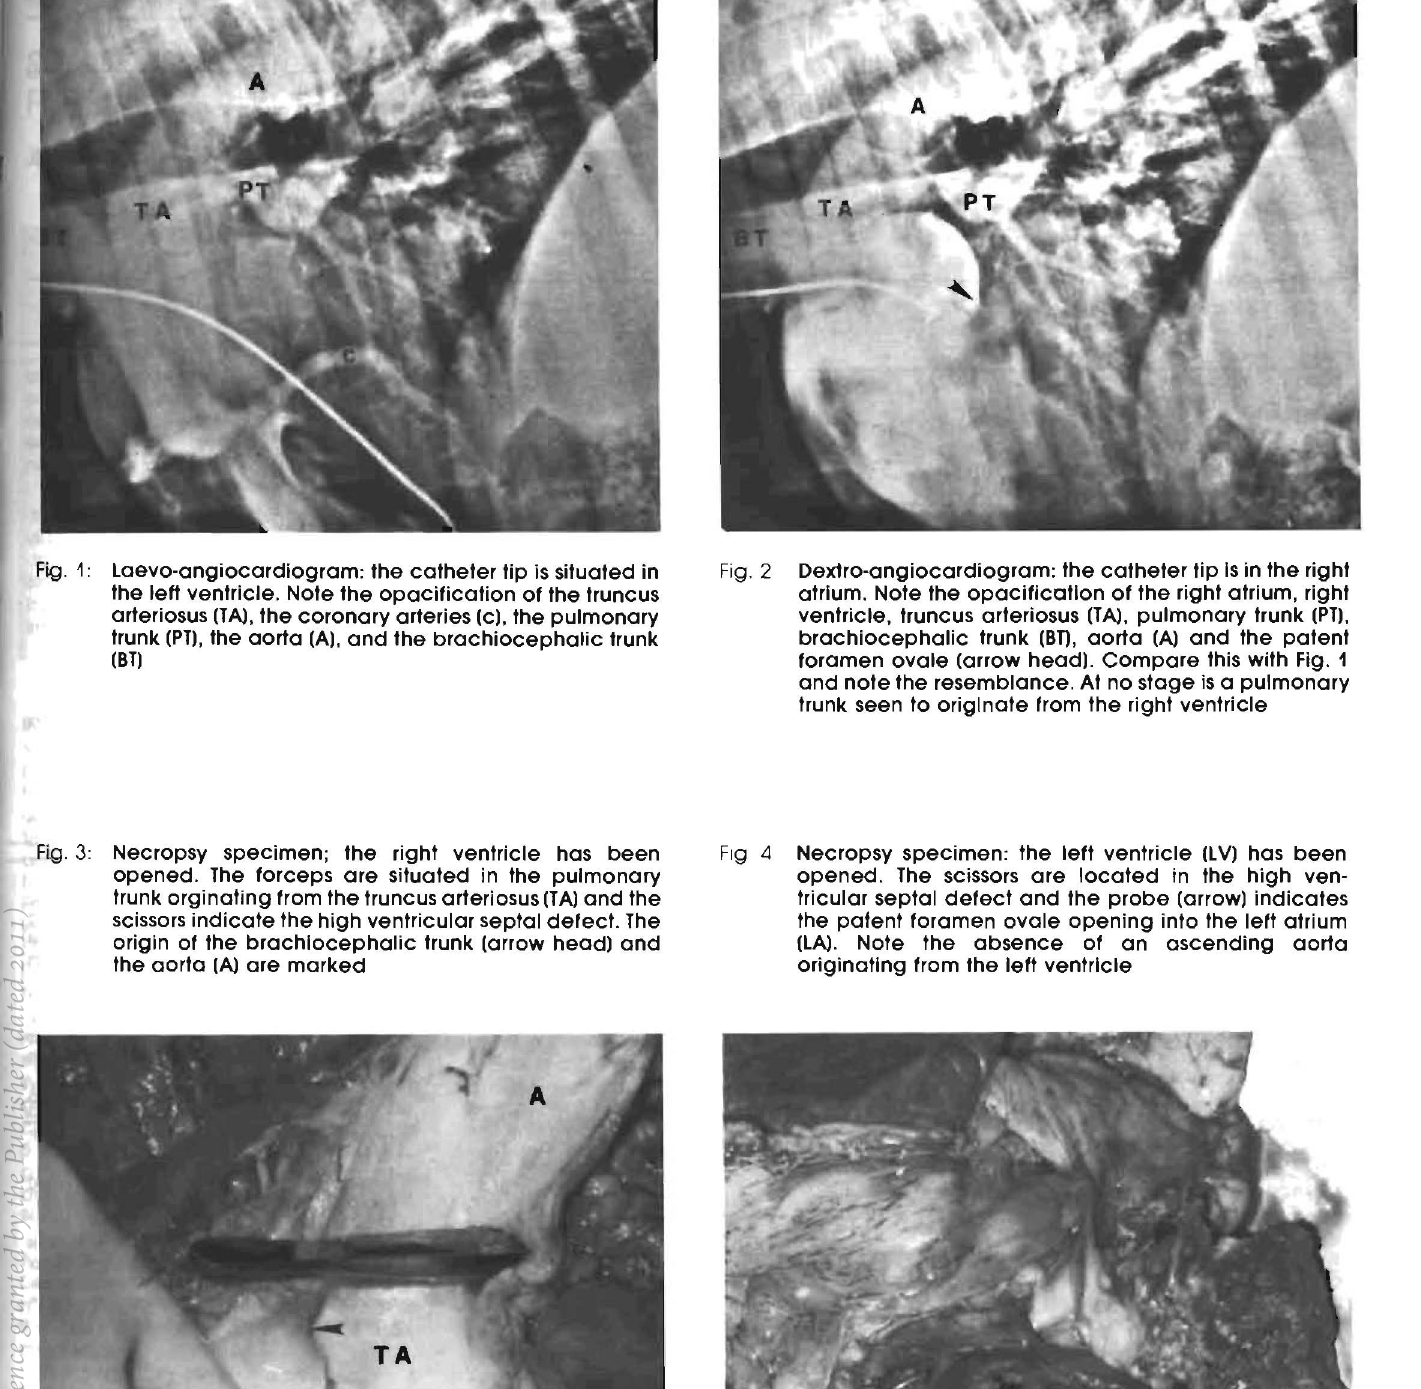
Fig. 3: Necropsy specimen; the right ventricle has been opened. The forceps are situated in the pulmonary trunk orginating from the truncus arteriosus (TA) and the scissors indicate the high ventricular septal defee!. The origin of the brachlocephalic trunk (arrow head) and the aorta (A) are marked